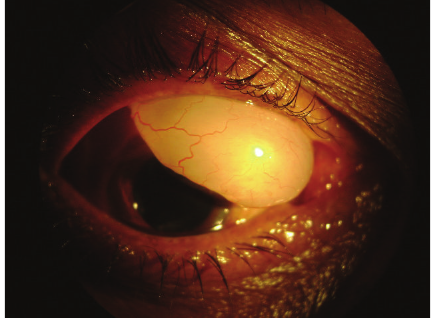
Figure 1: Filtration cystic bleb as seen through the upper eyelid in the first patient.